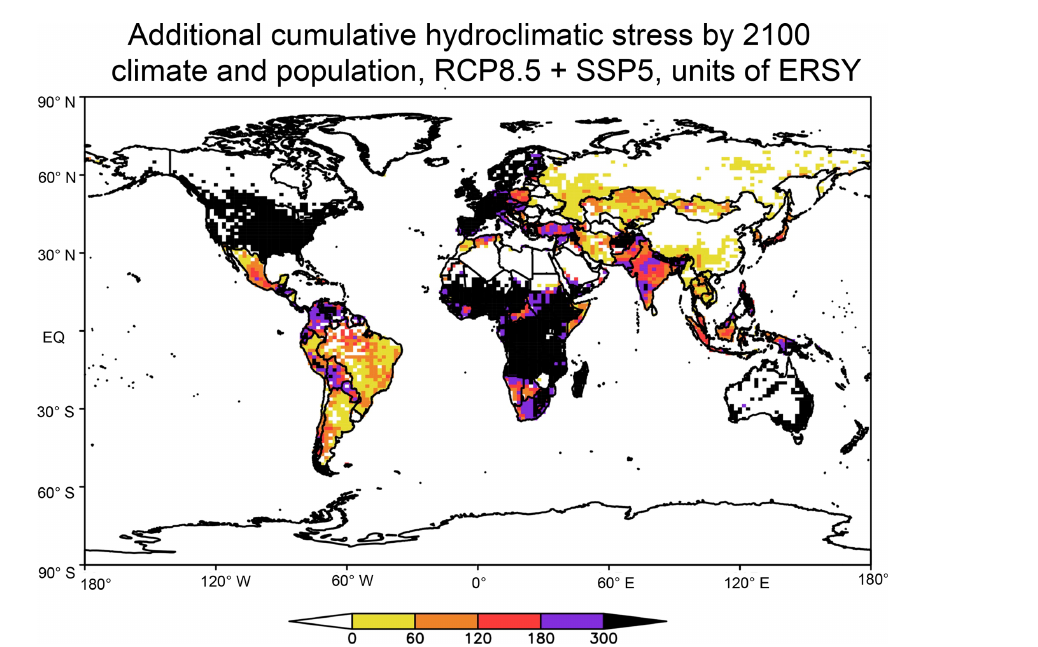
Figure 8. Same as Fig. 7, but with the inclusion of the SSP5 population scenario (see text for more